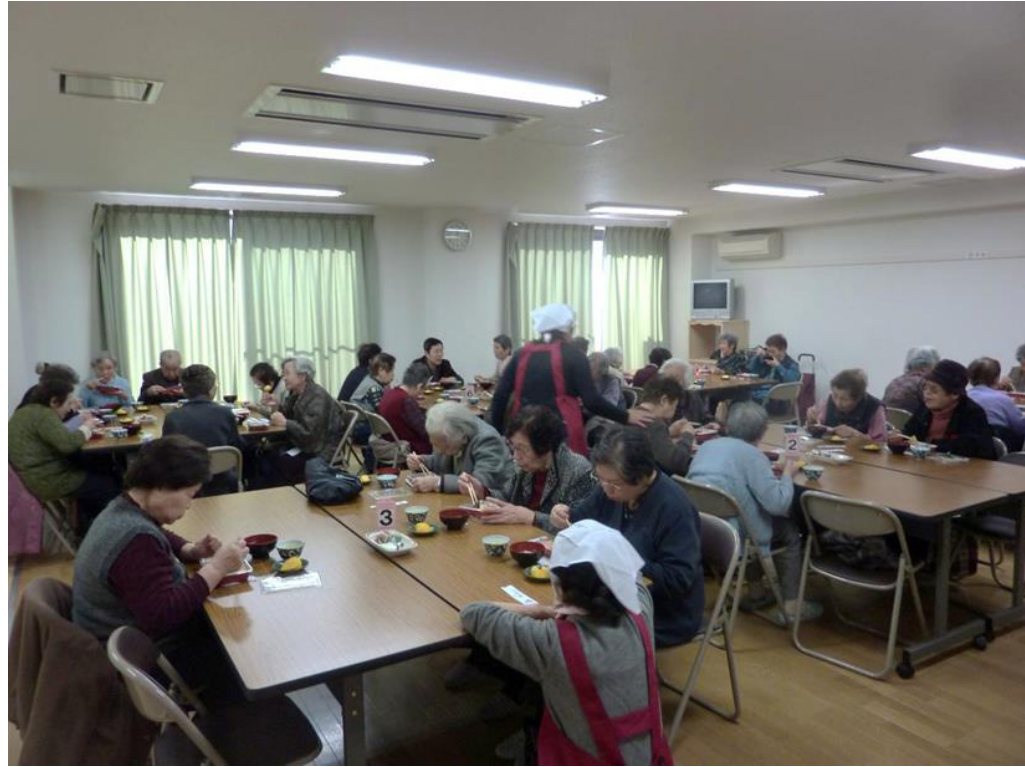
Figure 2.The food service for the elderly. Photo by the